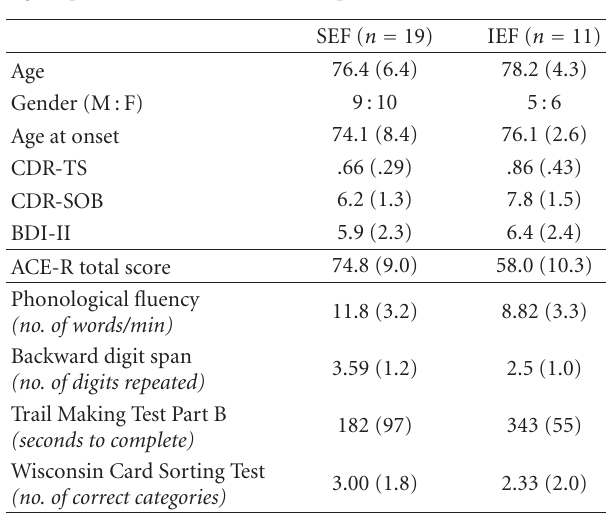
Table 1: Comparison of demographic variables and neuropsycho- logical performance for SEF and IEF patients.